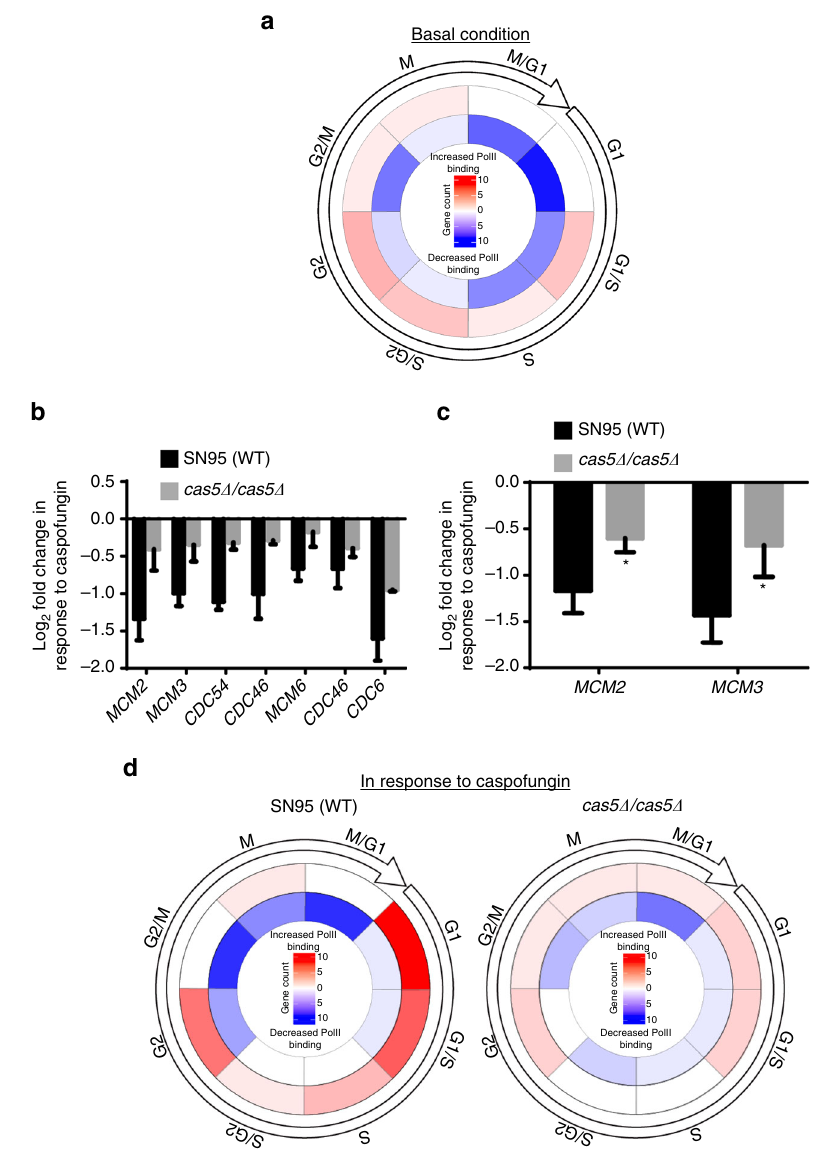
Fig. 4 Cas5 governs cell cycle dynamics under basal and cell wall stress conditions. a Circos plot depicting the number of genes with increased ( red ) and decreased ( blue ) RNA PolII binding in the cas5 Δ /cas5 Δ mutant whose normal expression in the wild-type peaks at the indicated cell cycle stage. b Cas5 is required for the decreased PolII binding at genes encoding MCM complex members and CDC6 in response to caspofungin. Histogram showing the PolII ChIP-Seq signal for the indicated genes encoding MCM complex components in response to caspofungin treatment. Error bars represent standard deviation (s.d.) from the mean of duplicate samples. c Downregulation of MCM2 and MCM3 in response to caspofungin depends on Cas5. Transcript levels were monitored by qRT-PCR and normalized to TEF1 . Error bars represent s.d. from the mean of triplicate samples. Signi fi cance was measured with an unpaired t test in GraphPad Prism (* P < 0.05). d Circos plots illustrating the number of genes with increased ( red ) or decreased ( blue ) PolII binding in response to caspofungin (CF) in wild-type and cas5 Δ /cas5 Δ strains for genes whose expression is regulated throughout the cell